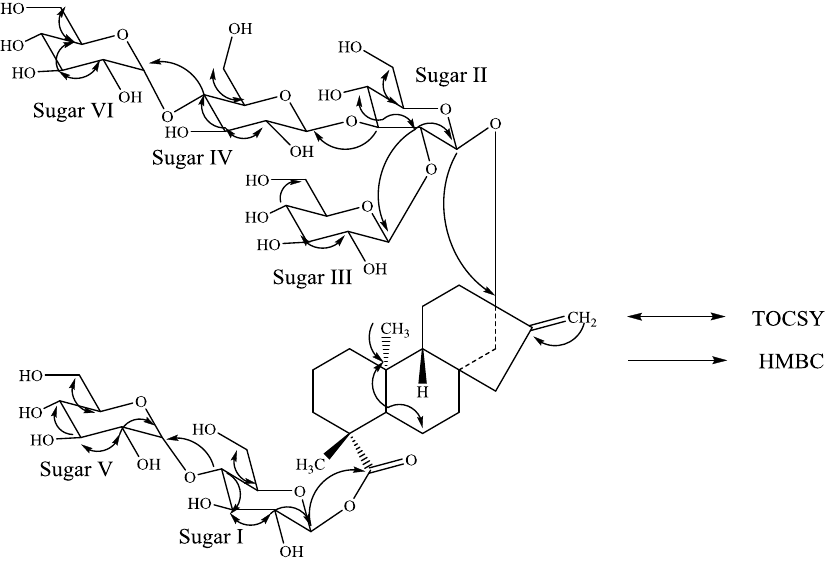
Figure 2. Key COSY and HMBC correlations of 1